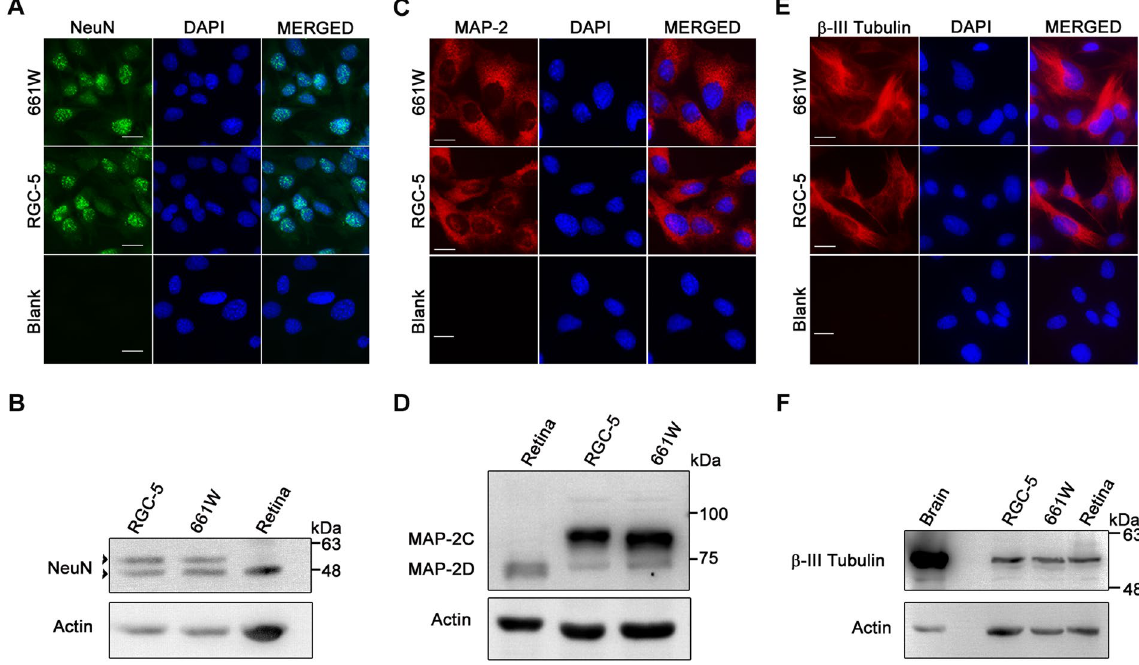
Figure 2. Expression of neuronal markers in 661W cells. ( A , C , E ) Immunostaining of 661W and RGC-5 cells for NeuN ( A ), MAP2 ( C ) and beta-III tubulin ( E ). Blank indicates negative control where cells are processed similarly without addition of primary antibody. Scale bar, 10 µ m. ( B , D , F ) 661W and RGC-5 cell lysates were resolved on SDS PAGE and blotted for the expression of NeuN ( B ), MAP-2 ( D ) and beta-III tubulin ( F ). Arrow heads indicate alternate isoforms of NeuN. Mouse retina was used as positive